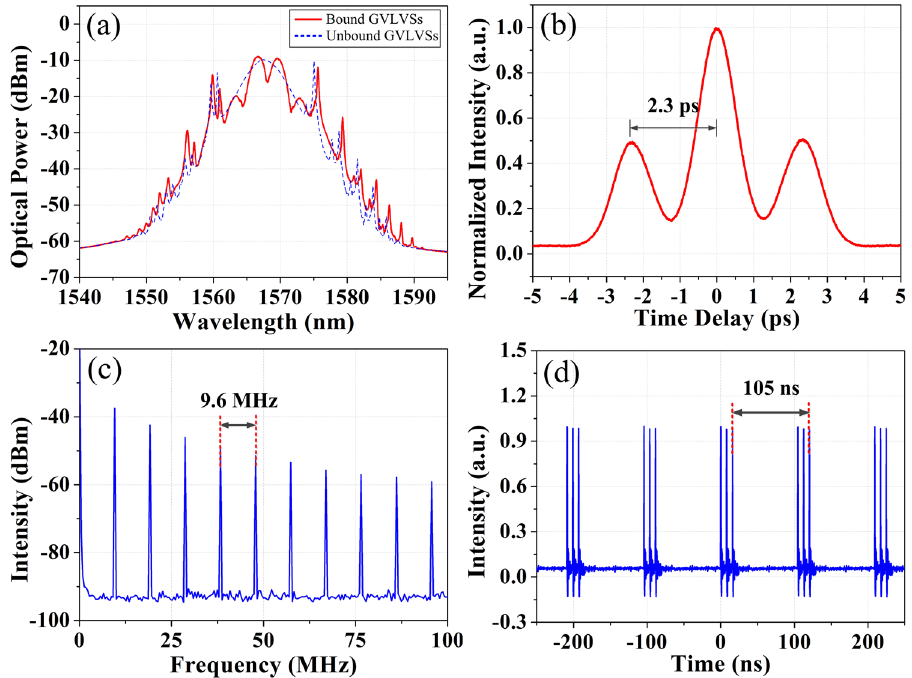
Figure 4. Group-velocity-locked vector soliton molecules. ( a ) Optical spectra of the GVLVSs and GVLVS molecules (dashed blue line and solid red line, respectively); ( b ) autocorrelation trace and ( c ) RF spectrum of the GVLVS molecules; ( d ) oscilloscope trace of the triple-pulse